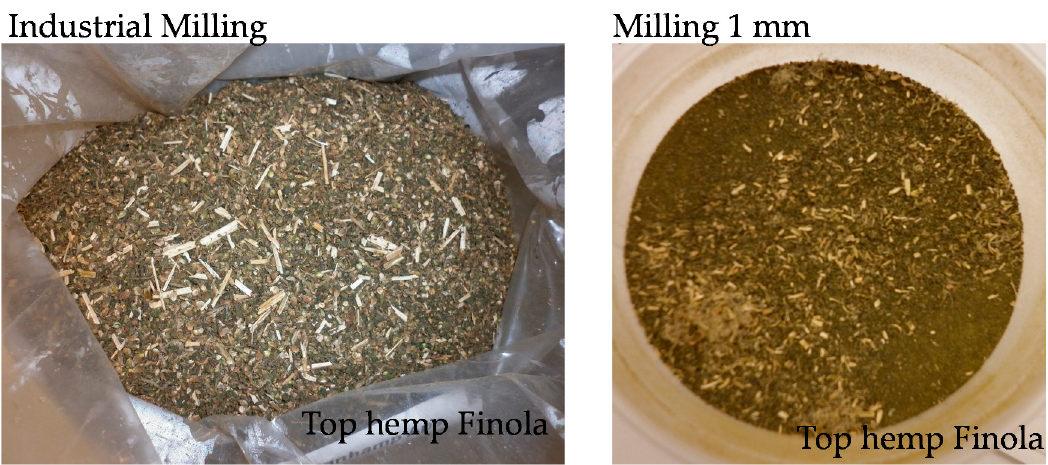
Figure 7. Examples of milled hemp. Top hemp, Cannabis sativa L. variety Finola was milled by means of industrial milling and subsequently further milled to pass through a 1-mm screen and homogenized.